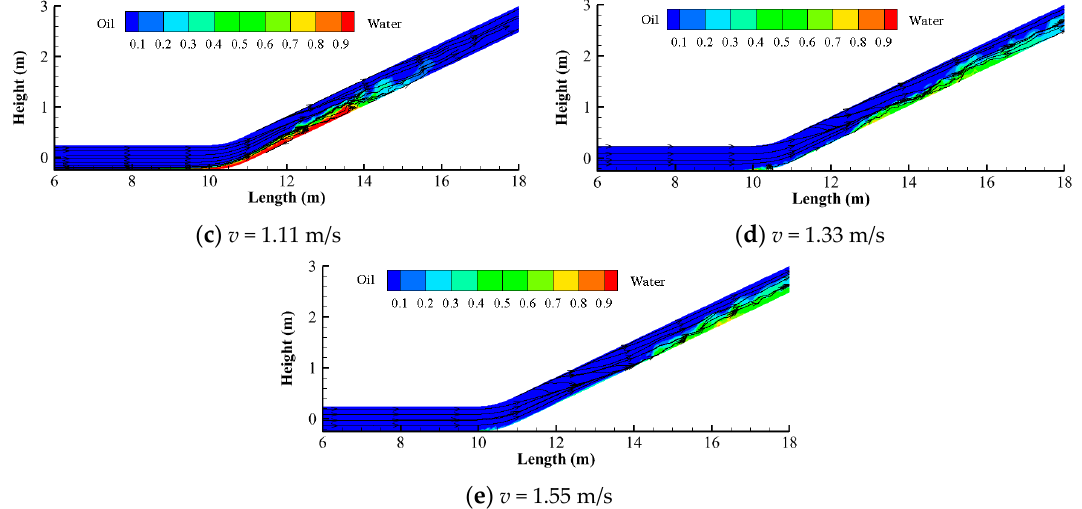
Figure 11. Distribution of oil and water ( α = 20°, t = 11.0 s).